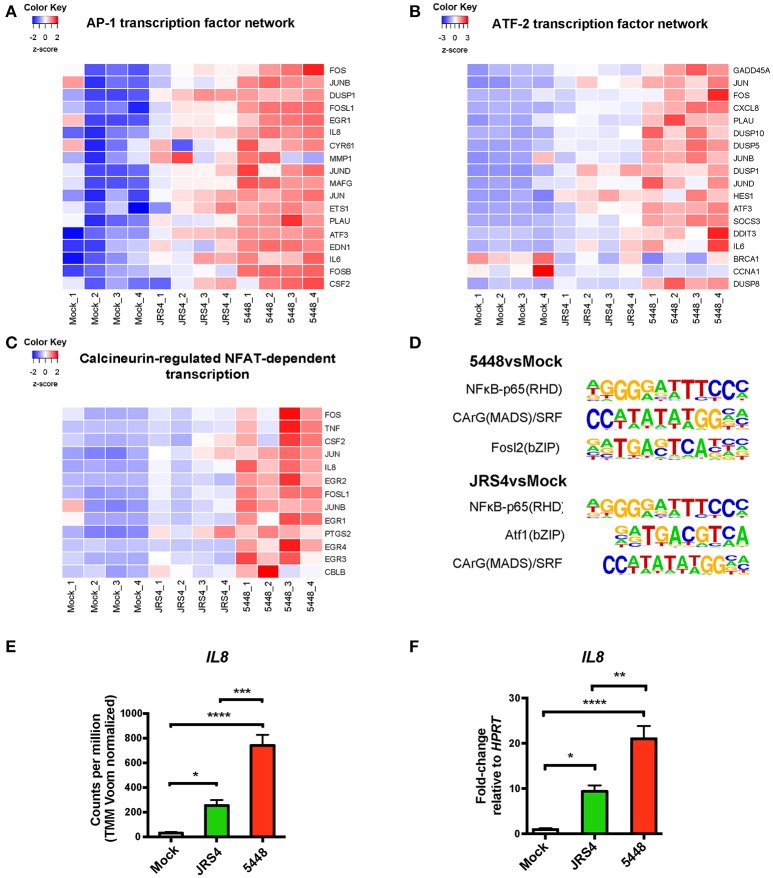
Regulated IL-8 expression in 5448 and JRS4 GAS-infected TEpi cells in comparison to mock cells. Heat maps of differentially expressed genes from top pathways enriched by Innatedb.com that induce IL-8 gene transcription. (A) AP1 transcription factor network, (B) ATF-2 transcription factor network, and (C) Calcineurin-regulated NFAT-dependent transcription. (D) Known transcription factor motifs enriched from top 400 differentially expressed genes for 5448-infected TEpi cells and JRS4-infected TEpi cells using HOMER motif analysis. 5448vsmock: NF-κB-p65 Rel homology domain (RHD) target sequences with motif = 42. CArG(MADS-domain)/Serum response factor (SRF) target sequences with motif = 21. Fosl2/basic Leucine Zipper (bZIP) target sequences with motif = 21. JRS4vsmock: NF-κB-p65(RHD) target sequences with motif = 38. Atf1/(bZIP) target sequences with motif = 58. CArG (MADS) target sequences with motif = 19. (E) RNAseq IL8 read counts. (F) qPCR of IL-8 mRNA levels, normalized to HPRT. Data in (E,F) (mean ± s.e.m.) are combined from at least three independent experiments performed in triplicate and analyzed by one-way ANOVA with Tukey's post-test. *P < 0.05; **P < 0.01; ***P < 0.001; ****P < 0.0001.